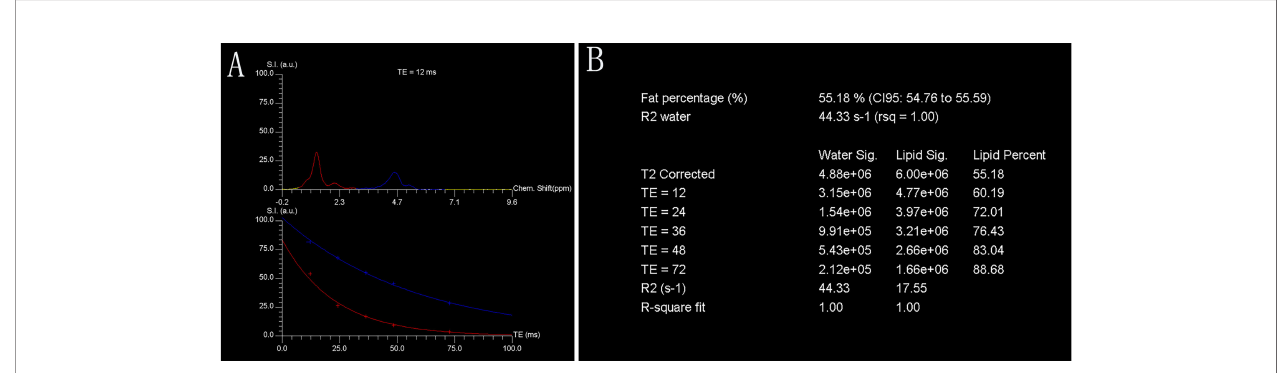
FIGURE 1 | Representative single-voxel T2-corrected multi-echo magnetic resonance spectroscopy. Fat and water spectral peaks at echo time of 12 ms are presented. Red curve denotes fat spectrum (bulk methylene protons at 1.30 ppm), and blue curve denotes water spectrum (H 2 O at 4.7 ppm) (A) . Each fat and water integral at fi ve echoes (echo time = 12, 24, 36, 48, and 72 ms, respectively) with estimated marrow PDFF of 55.18% (B) . Chem., chemical; CI, con fi dence interval; FF, fat fraction; rsq, r-squared; S.I. (a.u.), signal intensity (arbitrary units); TE, echo